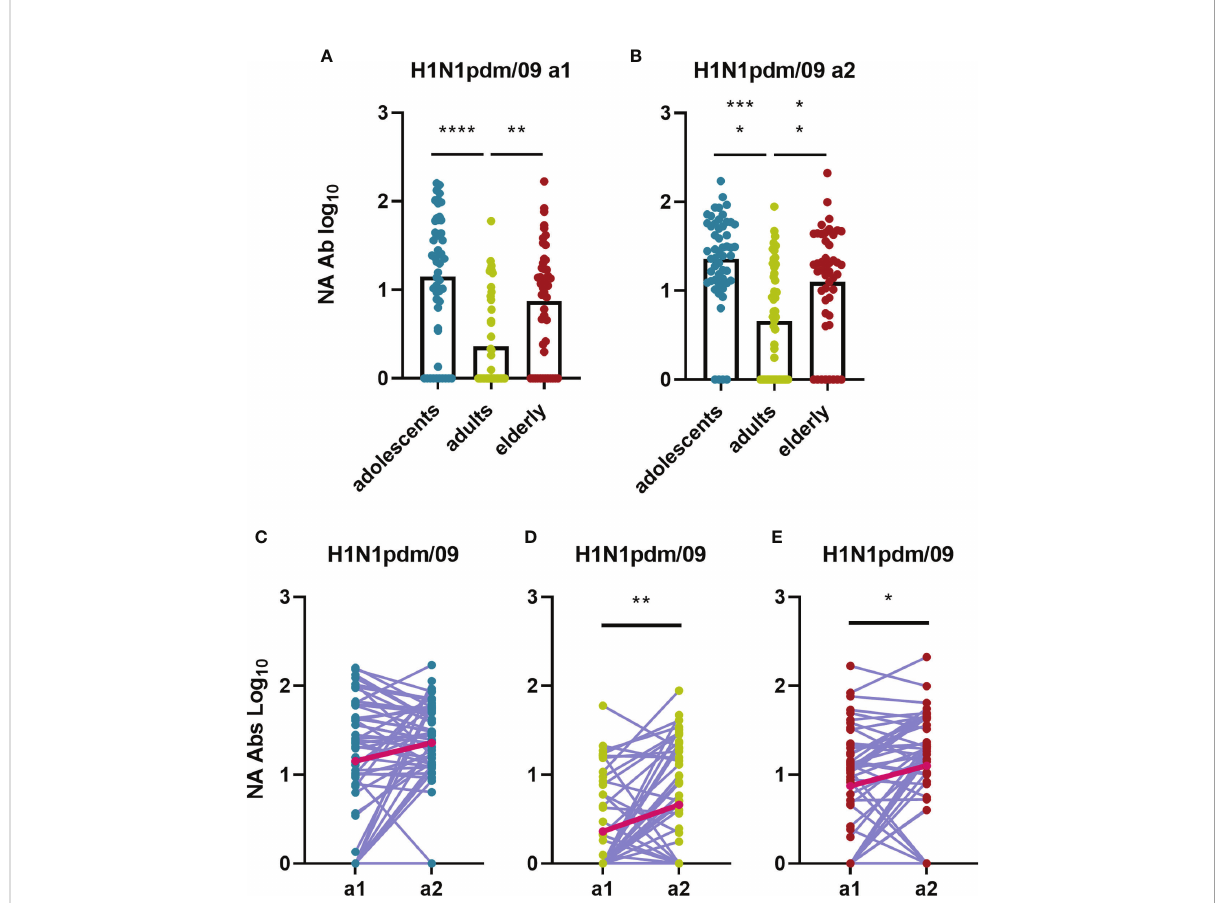
FIGURE 9 Birth year-related differences in in fl uenza H1N1pdm09 speci fi c NA antibody titers and how these change over time during a 5-years interval. Antibodies inhibiting the NA of the H1N1pdm09 strain were determined by ELLA and are depicted for the different age groups for assessment 1 (A) and assessment 2 (B) . Changes in NA-inhibiting antibody levels between a1 and a2 are indicated for adolescents [ (C) n=53], adults [ (D) n=48] and elderly [ (E) n=47]. In (A, B) data were analyzed using Kruskal Wallis test followed by Dunn ’ s post-hoc test for multiple comparison. In ( C, D ) and E Wilcoxon matched-pairs signed rank test was performed to show signi fi cant differences. GM is indicated with a red line in (C – E) . *P ≤ 0.05; **P ≤ 0.01; ***P ≤ 0.001; ****P ≤